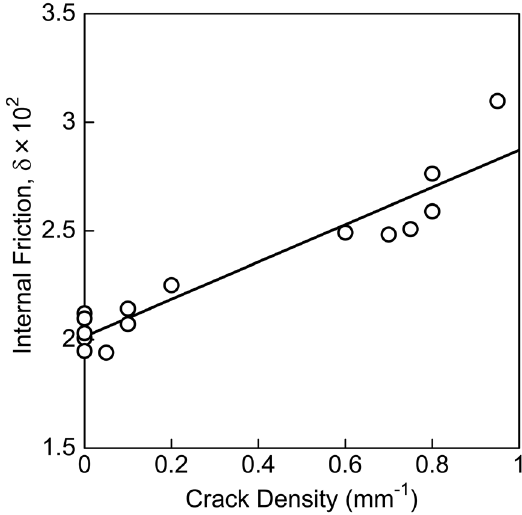
Figure 2. Relation between amplitude-independent internal friction δ and crack density in CFRP laminates subjected to fatigue cycling of N = 10 2 -10